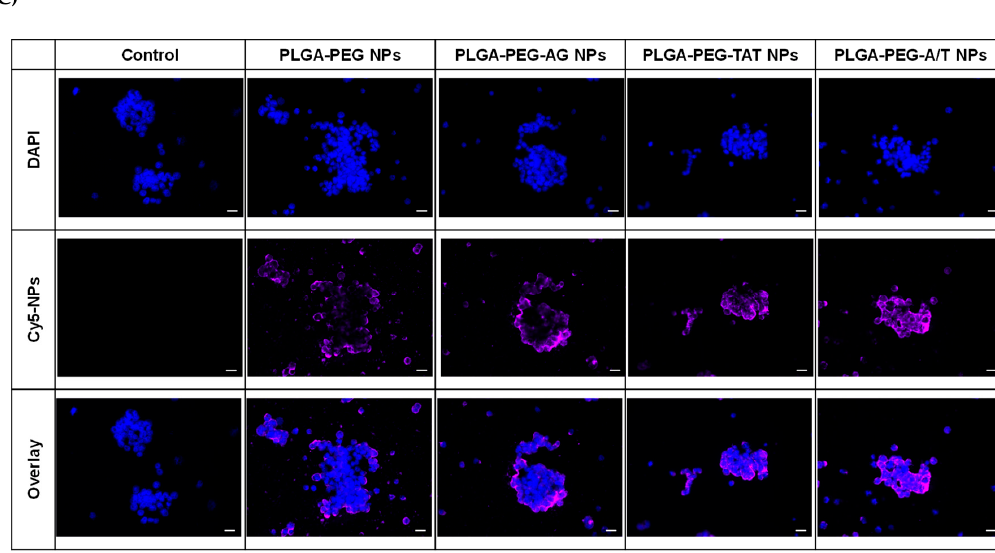
Figure 4. Flow cytometric analysis of cellular uptake of PLGA-PEG NPs, PLGA-PEG-AG NPs, PLGA- PEG-TAT NPs and PLGA-PEG-A/T NPs in ( A ) CD133(+) H69 and ( B ) A549 cell lines for 2 h (* p < 0.05, ** p < 0.01, *** p < 0.001, n = 3) and ( C ) fluorescence microscopic images of CD133(+) H69 cells treated with medium only and Cy5 loaded NPs (scale bar: 20 μ m).